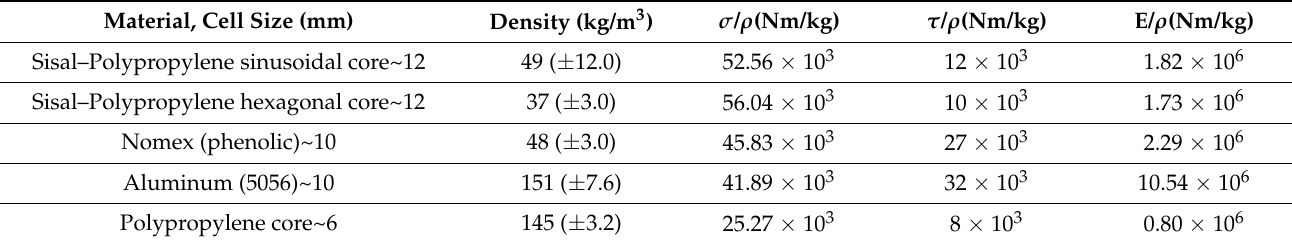
Table 4. Specific mechanical properties of the sisal–polypropylene core